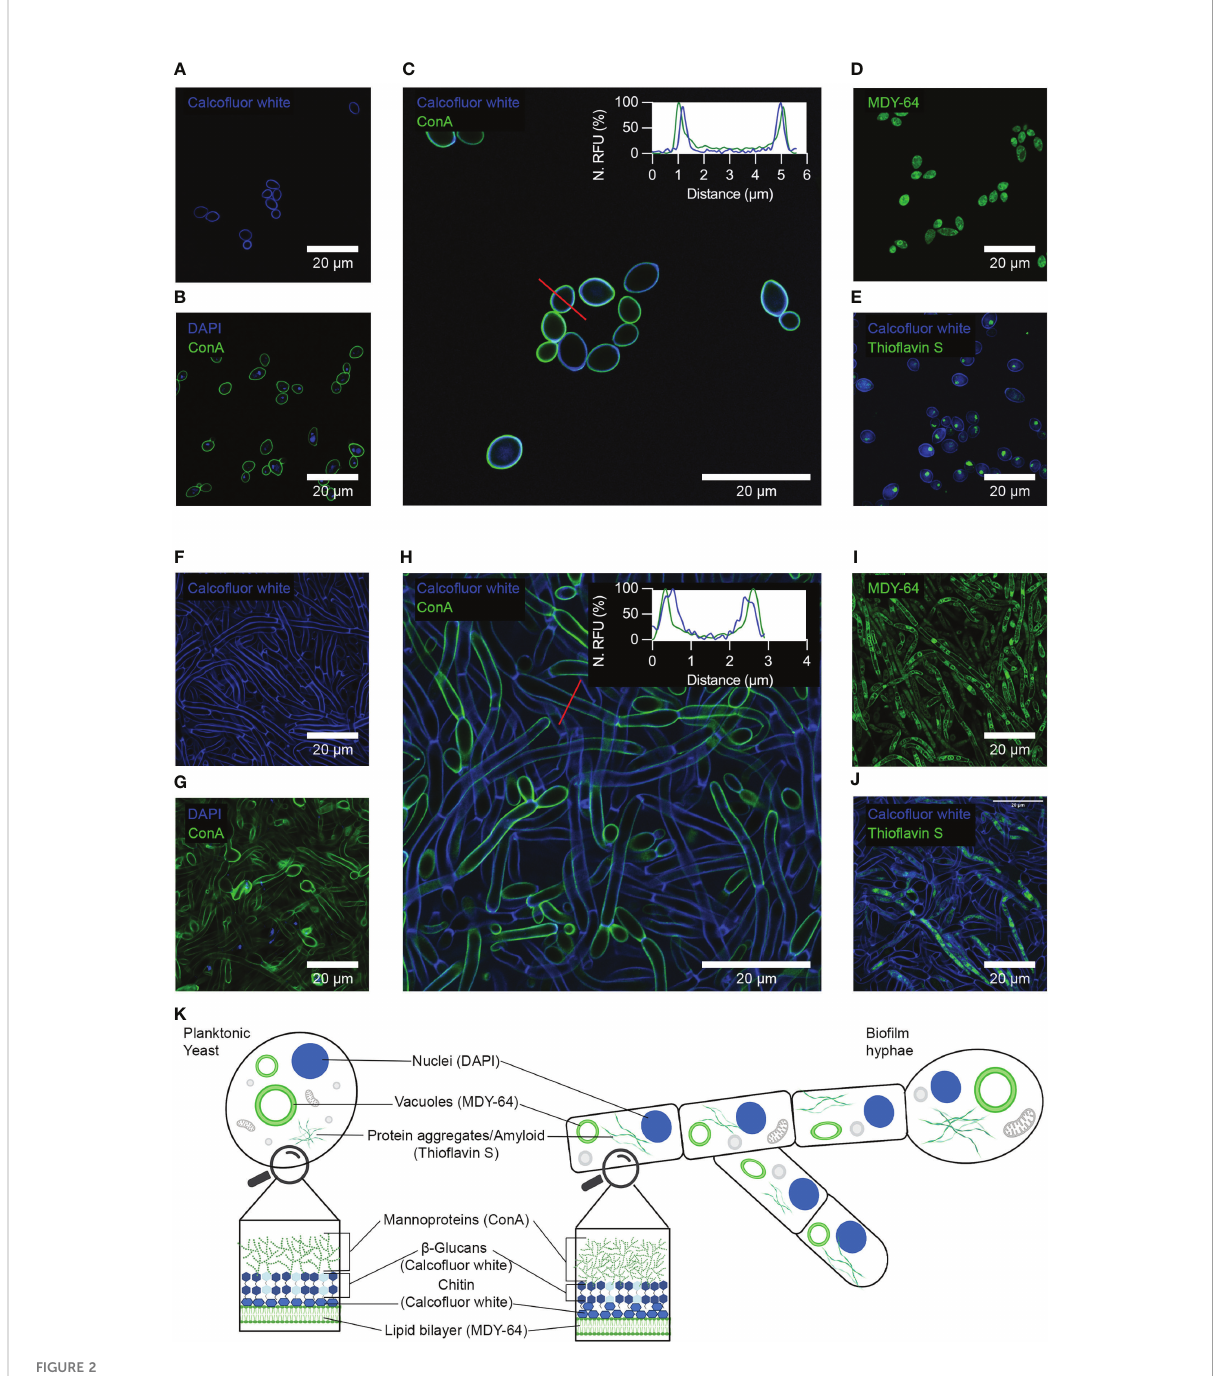
FIGURE 2 Immuno fl uorescence analysis of yeast cells and bio fi lms using conventional molecular probes for fungi. Confocal microscopy showing yeast cells stained with (A) calco fl uor white, (B) DAPI and Alexa488 conjugated Concanavalin A (ConA), (C) calco fl uor white and ConA, (D) MDY-64, and (E) calco fl uor white and thio fl avin S. Confocal microscopy of bio fi lms stained with (F) calco fl uor white, (G) DAPI and ConA, (H) calco fl uor white and ConA, (I) MDY-64, and (J) calco fl uor white and thio fl avin S. The embedded graphs in C and H show normalized fl uorescence intensities of calco fl uor white and ConA plot as a line pro fi le. Red lines show the location of the line pro fi le. (K) Schematic summary of the immuno fl uorescence analyses of yeast cells and bio fi lms, showing materials and organelles detected and the corresponding molecular probe used. Representative images of three independent experiments are